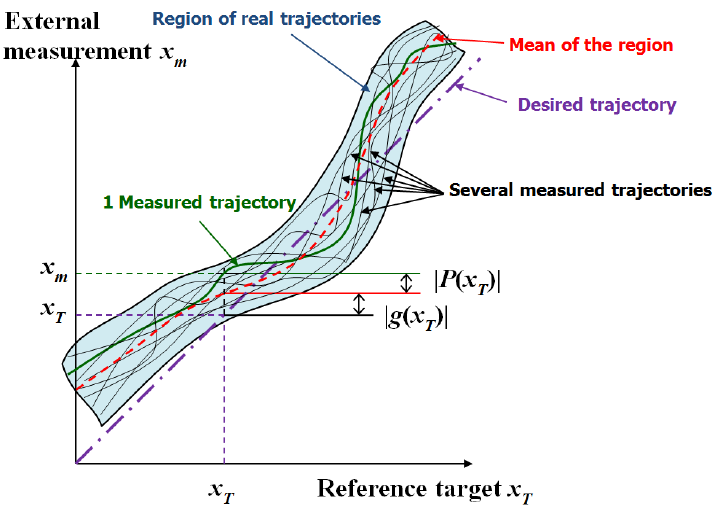
Figure 1. Geometric representation of every component of input-output of the 1-DoF nanopositioning stage without thermal drift D ( t )